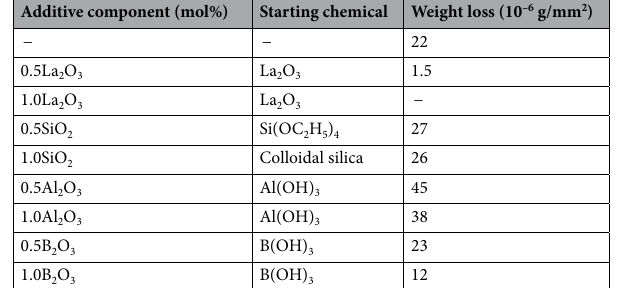
Additive component (mol%) Starting chemical Weight loss (10 –6 g/mm 2